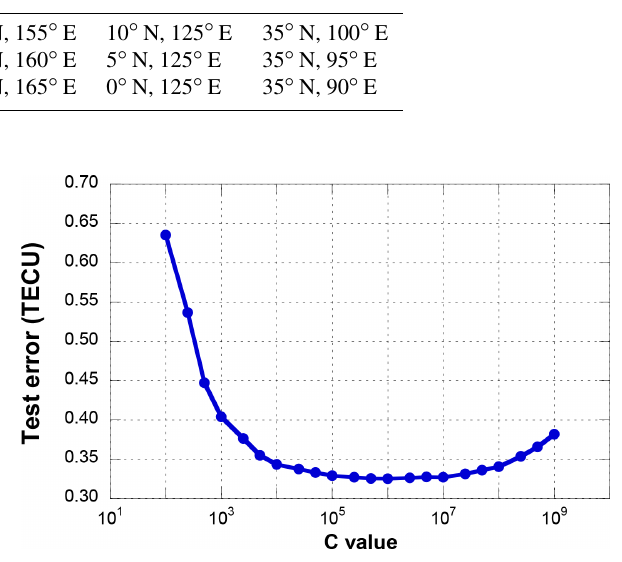
Figure 5. Test errors of different numbers of hidden neurons by the NN model (5 ◦ extrapolation point).